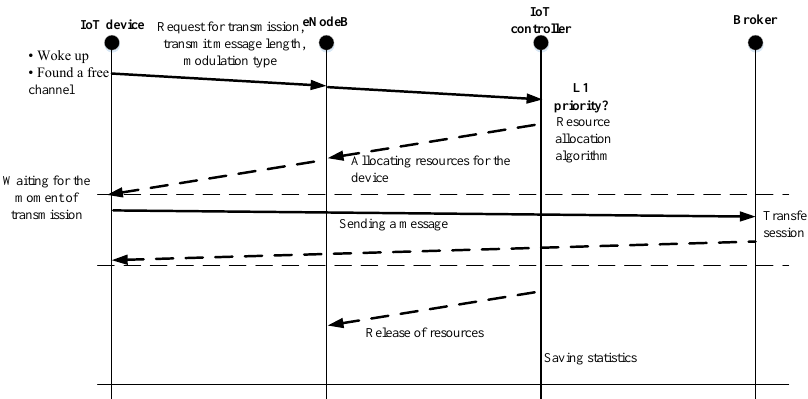
Figure 6. Interaction of Long-Term Evolution/Internet of Things LTE/IoT network elements when transmitting L1 message.